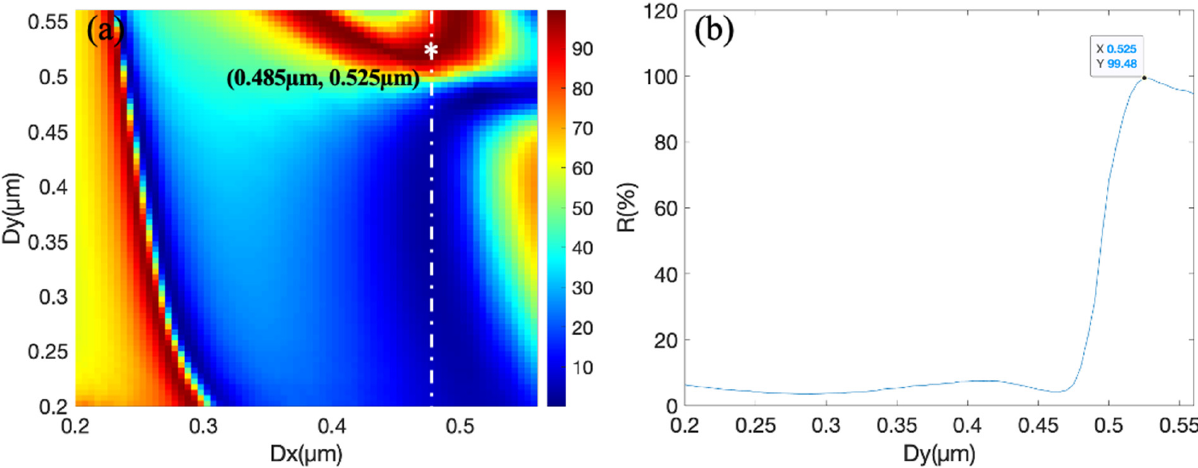
Figure 2. Reflectance of Si nanoholes: ( a ) Reflectance as a function of D x and D y; ( b ) Reflectance as a function of D y when D x = 0.485 µm. Here, the heights of the nanoholes are constant H = 200 nm, and the lattice period P is 600 nm.